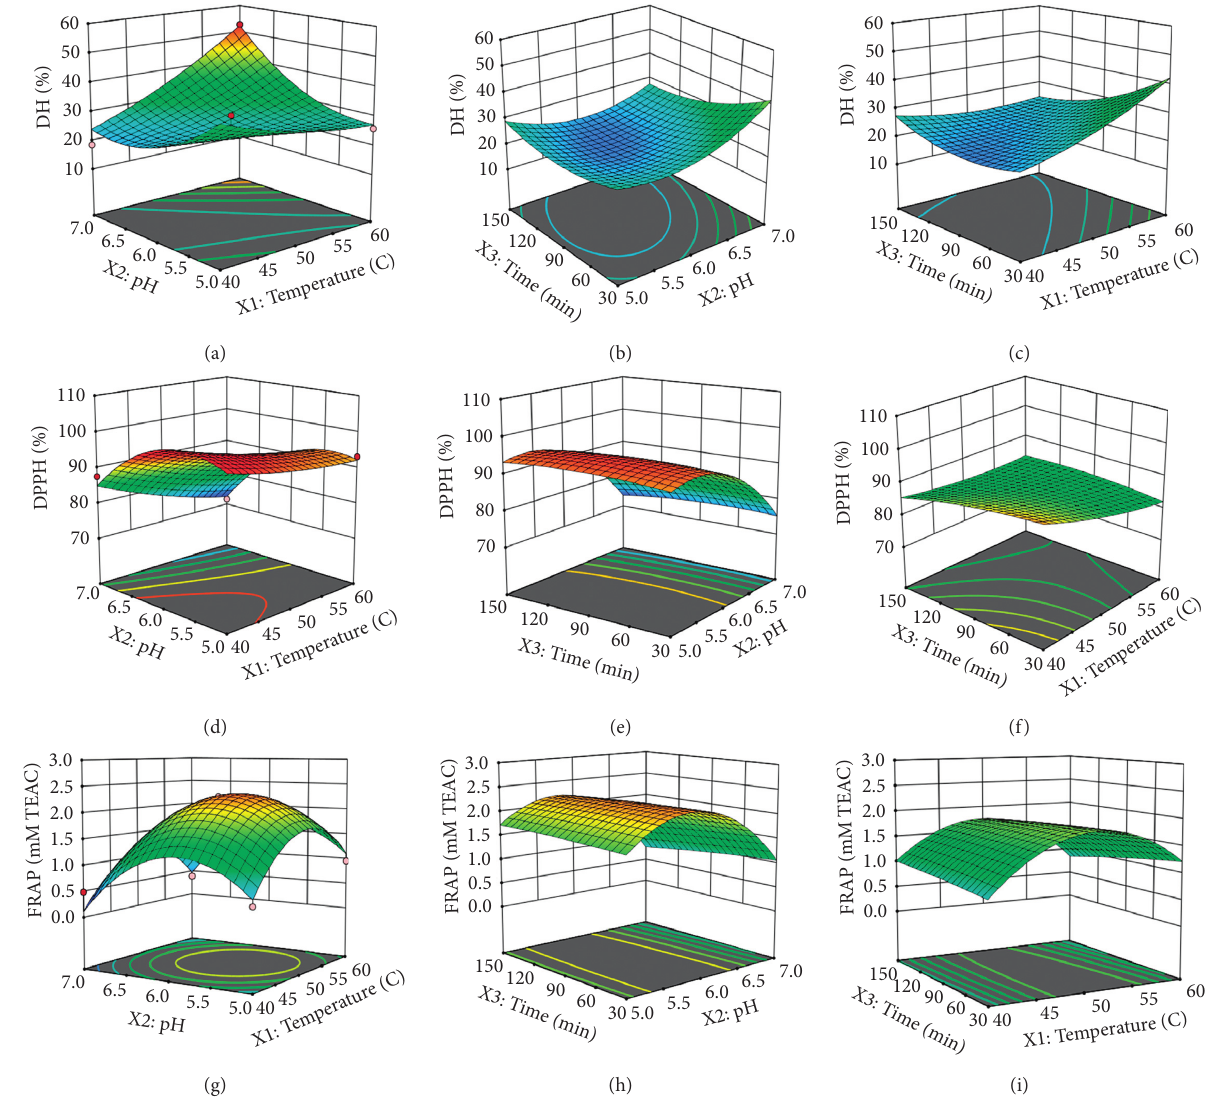
Figure 1: Response surface plots for degree of hydrolysis (a-c), DPPH scavenging activity (d-f), and FRAP (g-i) for spent hen meat